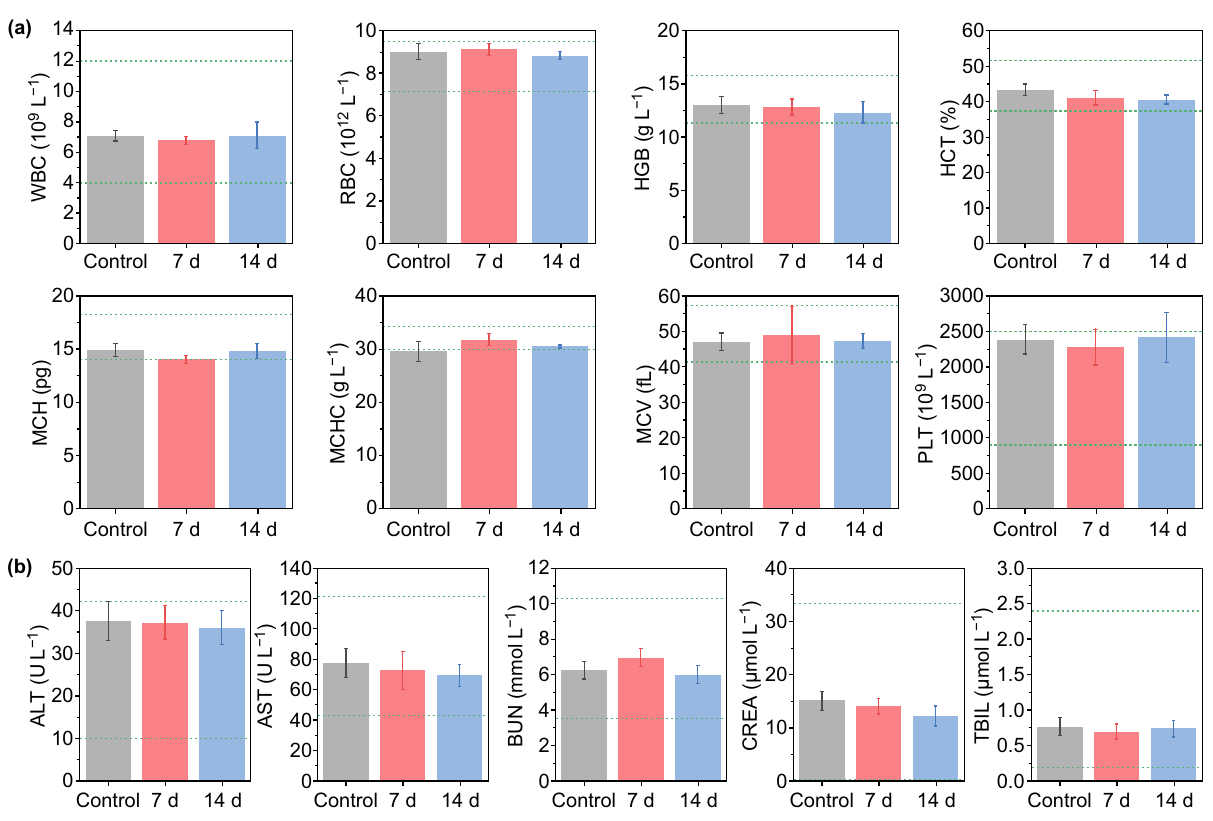
Fig. 6 In vivo toxicity evaluation. a Hematological index (WBC, RBC, HGB, HCT, MCH, MCHC, MCV, and PLT) of the mice in control, 7 d post-injection, and 14 d post-injection groups. b Biochemical blood analysis (ALT, AST, BUN, CREA, and TBIL) of the mice in control, 7 d post-injection, and 14 d post-injection groups (the results are presented as mean ± SD, n =